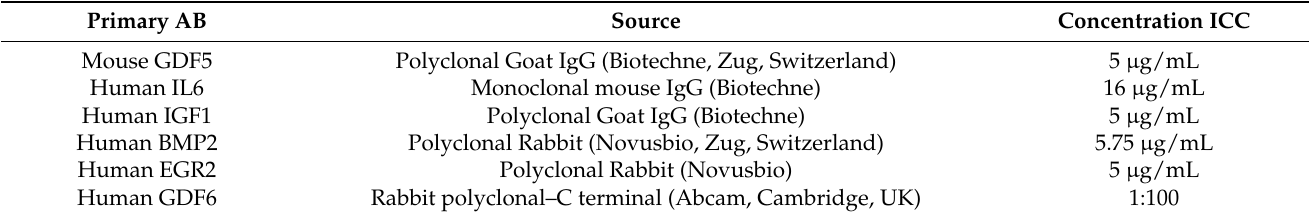
Table 3. Primary antibodies used for immunohistochemistry.